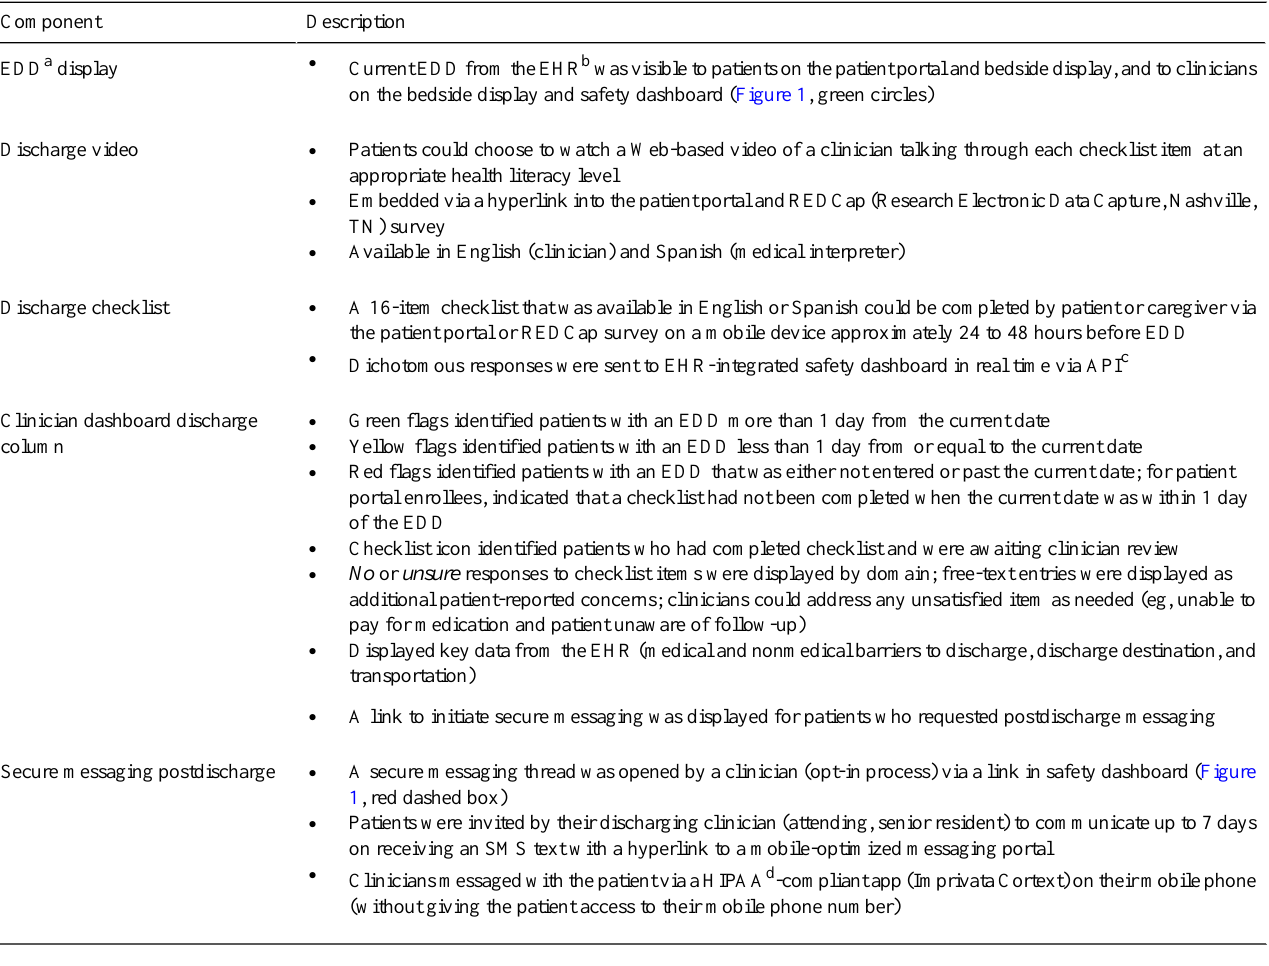
Table 2. Description of core components of the patient-centered discharge toolkit. Patient-facing Patient Safety Learning Laboratory (PSLL) tools: patient portal and bedside display; clinician-facing PSLL tools: bedside display and safety